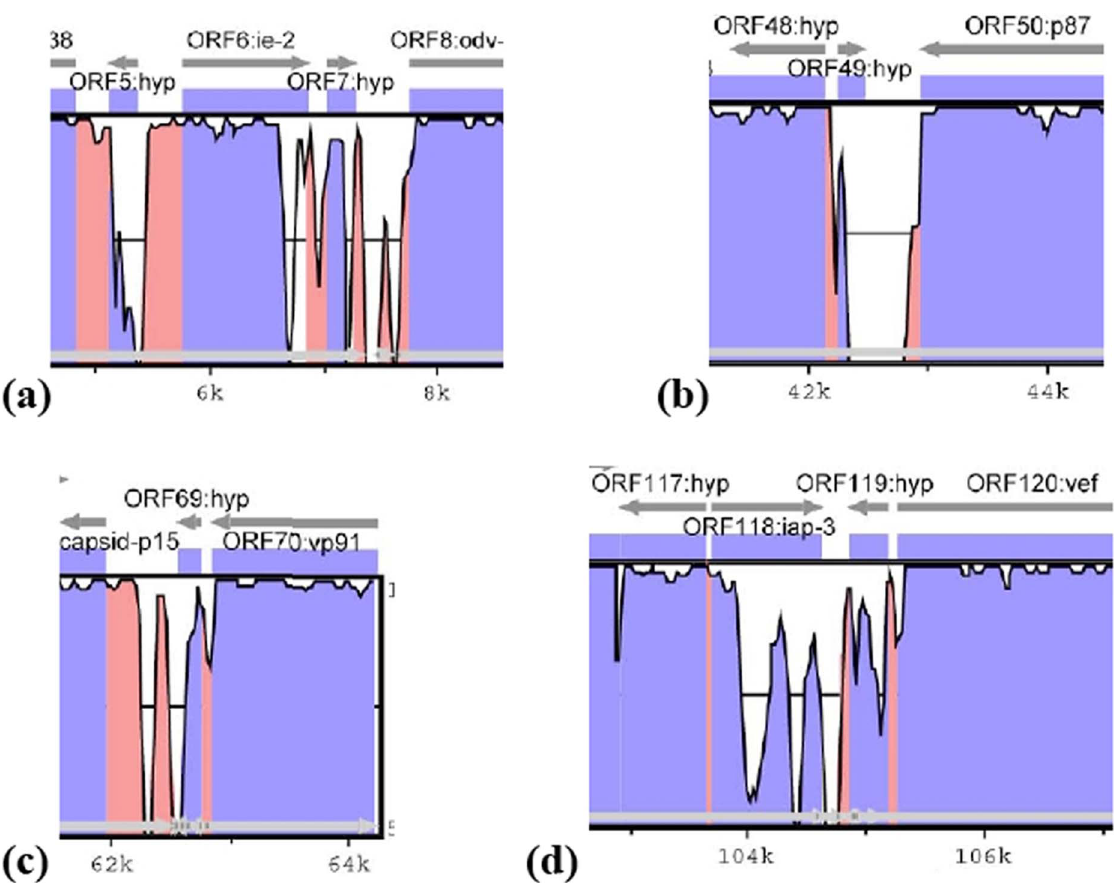
Figure 3. Vista analysis. Graphical representation of the most divergent regions of the ChocNPV and CfMNPV genomes. The plots were generated using wgVista tool. Blue and red colors represent coding and non-coding sequences, respectively. Peaks and valleys represent percent conservation between aligned sequences at a given coordinate. The top and bottom lines represent 100% and 50% identity, respectively. Above the top line are ORF numbers, names, and orientation. Overall, five most divergent regions were identified, with section (a), containing two regions.